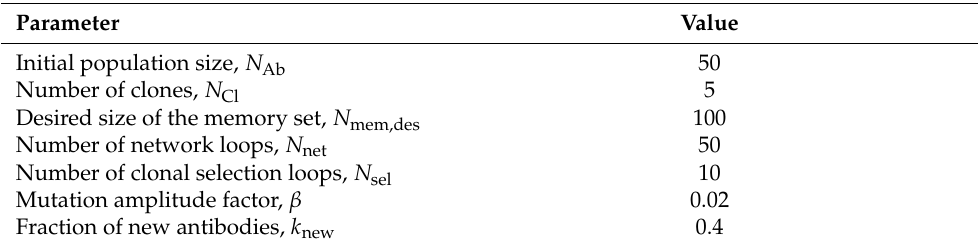
Table A1. Values adopted for the parameters of VIS in all optimisation